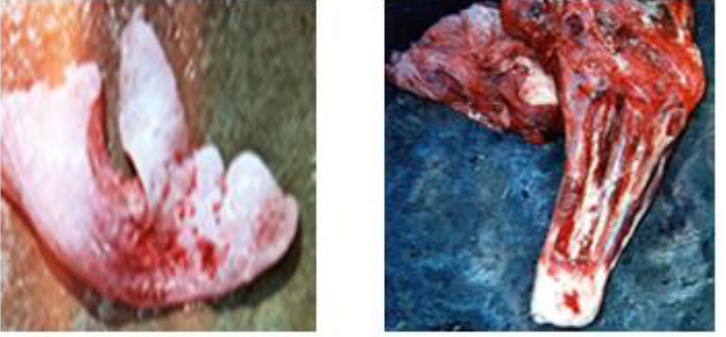
Figure 5. Traumatic carcass (Tissue rupture with hemorrhage).